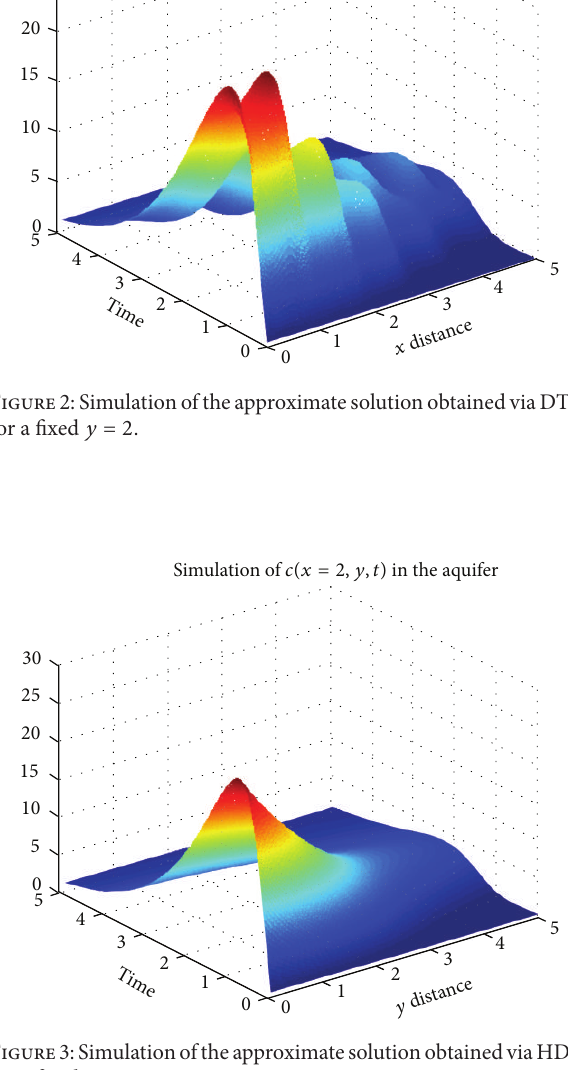
Figure3:SimulationoftheapproximatesolutionobtainedviaHDM for a fixed 𝑥 = 2 .